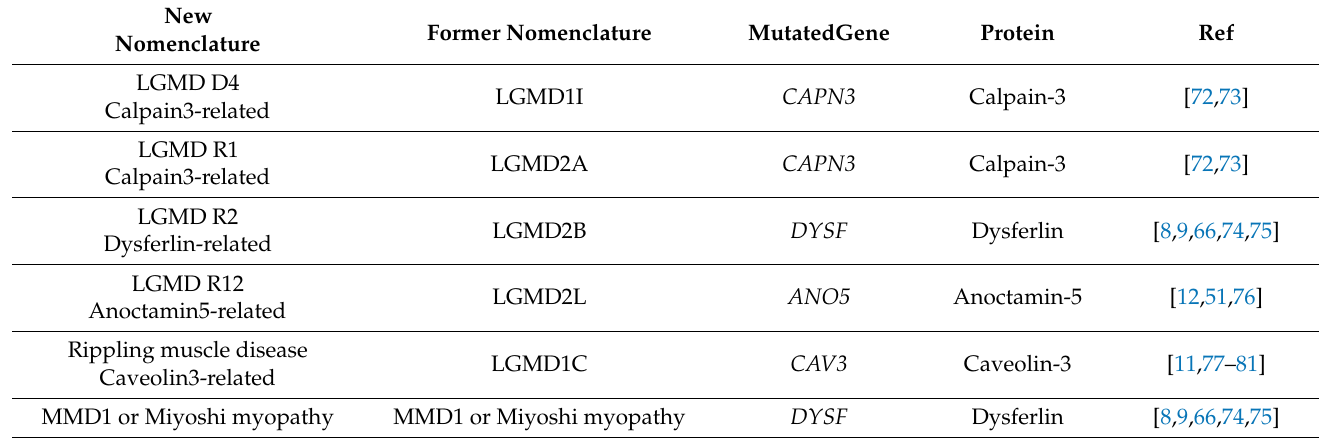
Table 2. Overview of muscular dystrophies linked to deficiency in sarcolemma